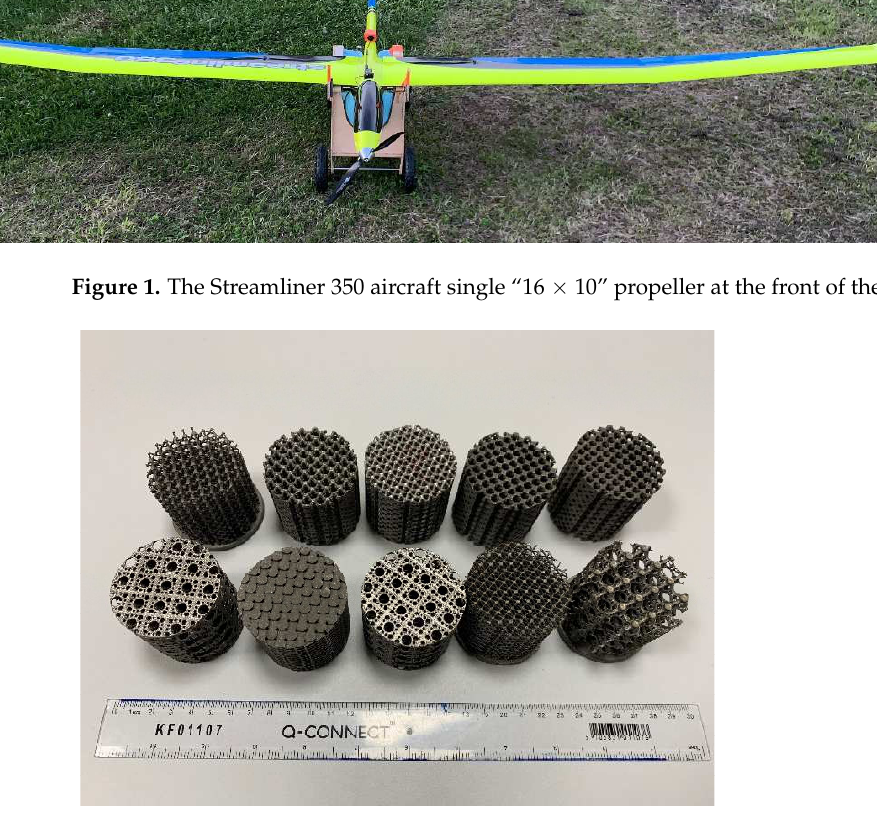
Figure 1. The Streamliner 350 aircraft single “16 × 10″ propeller at the front of the fuselage.